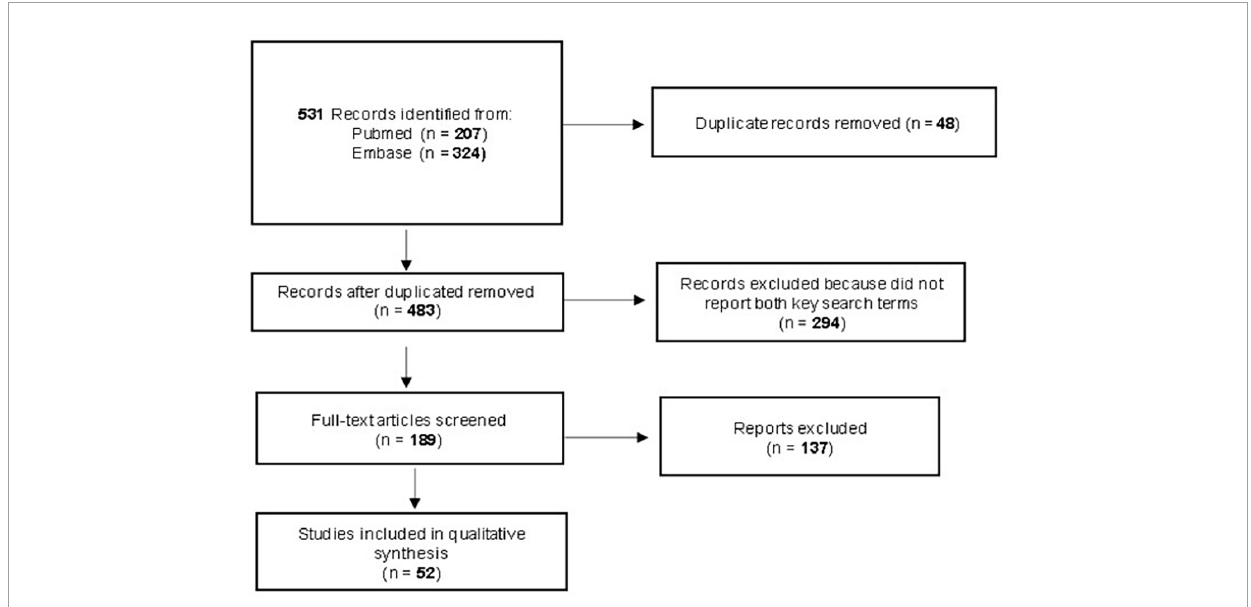
FIGURE1 Preferring reporting items for systematic reviews and meta analyses flow diagram.